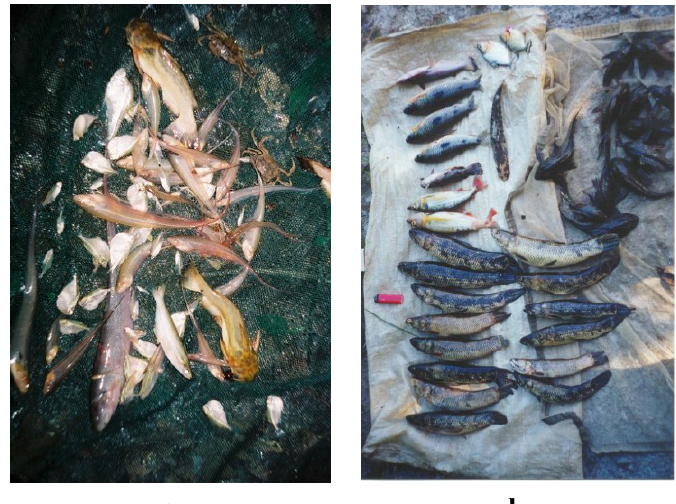
Figure 5. Impact of small-scale gold mining on fish communities of rainforest streams as revealed by fish collections from two small rainforest streams in Suriname; ( a ) Surface feeding hatchet fishes and nocturnal electric knife fishes and catfishes dominate the catch in a mining-impacted stream; note the unpigmented or silvery colours of the fishes; ( b ) Large diurnal piscivores ( Hoplias spp.) and brightly coloured fishes dominate the catch in an undisturbed neighbouring stream. See Mol and Ouboter [34] for